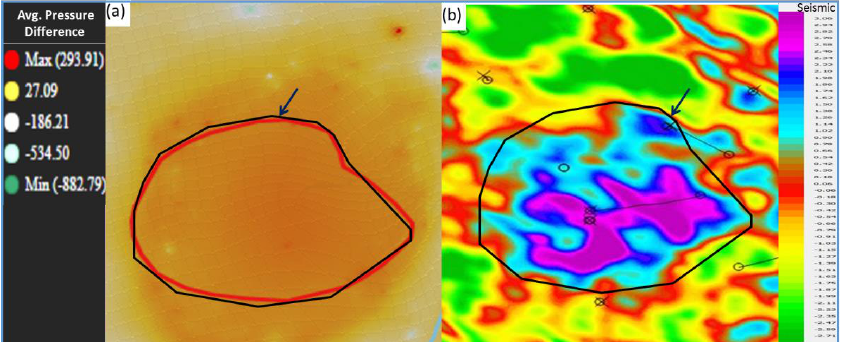
Figure 14. ( a ) Changes in pressure saturation over the 20-year period, and ( b ) horizon slice difference between baseline and the monitor survey. The black polygon indicates the average pressure difference and the higher amplitude of the seismic difference.